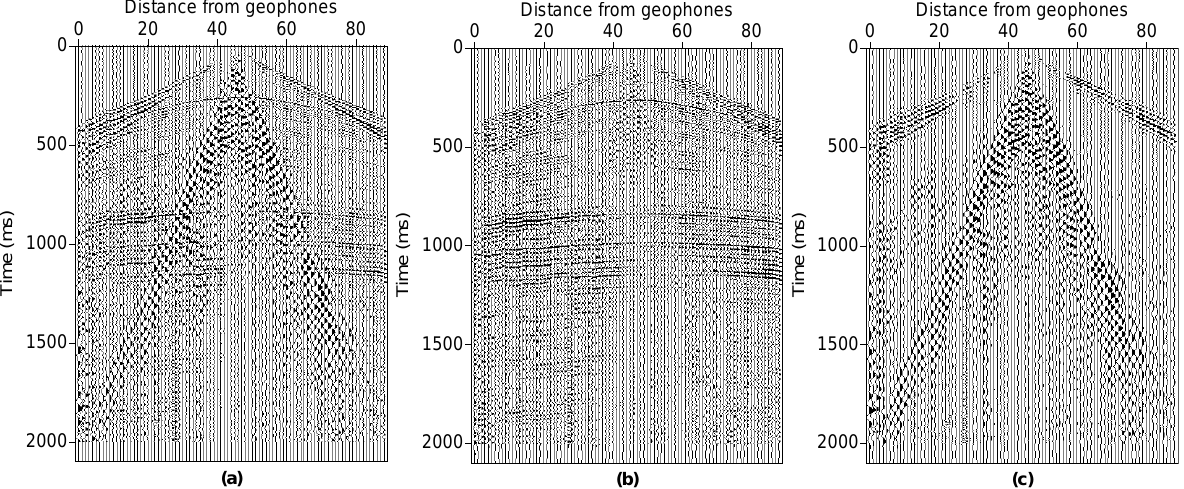
Fig. 1. (a) The original seismic data where the ground roll is present. It corresponds to record 25 as describe in Yilmaz’s book. (b) This is the result after suppression of the ground roll. (c) The suppressed portion of the original seismic data.